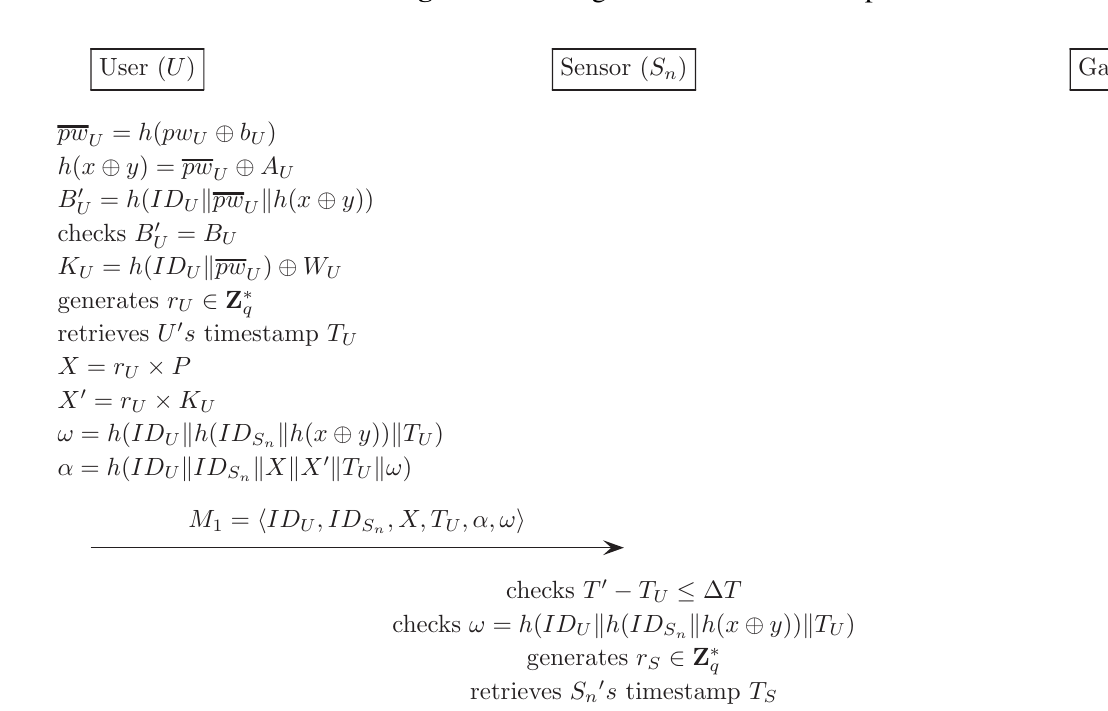
Figure 8. The login and authentication